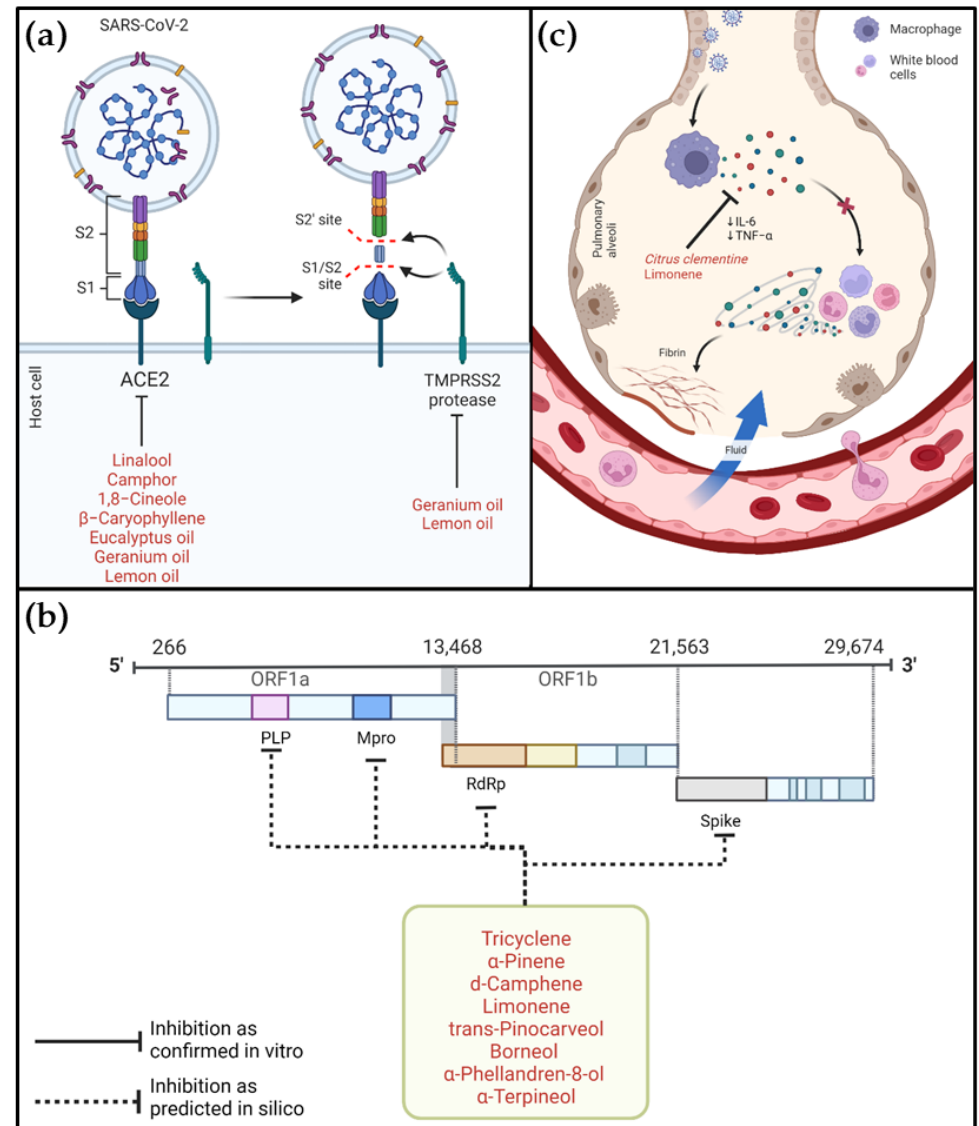
Figure 2. Mechanism of action of essential oil as anti-SARS-CoV-2 by blocking the ACE2 and TMPRSS2 as viral entry points ( a ) and inhibiting the viral proteins ( b ). Excessive release of cytokine by the immune system following SARS-CoV-2 infection causes a cytokine storm which could be treated by using Citrus clementine and limonene ( c ). Essential oils acting as anti-SARS-CoV-2 agents are presented in red.